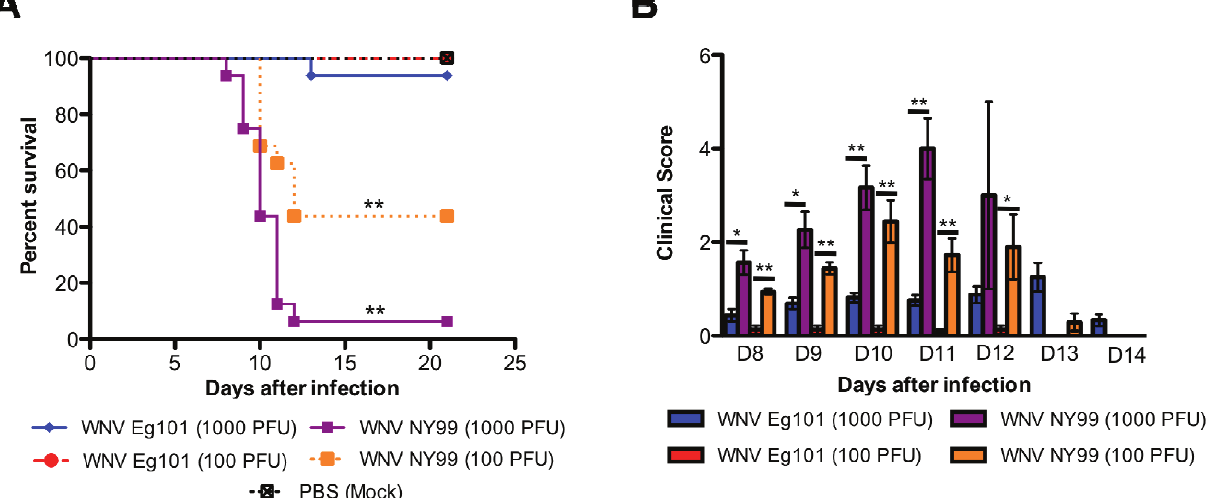
Figure 1. Survival analysis and clinical score of WNV Eg101 and WNV NY99 infected mice. ( A ) Eight-week old C57BL/6J mice were inoculated subcutaneously with 1000 or 100 PFU of WNV Eg101 or WNV NY99. A group of mice were also inoculated with PBS (Mock). All mice were observed for 21 days. Data are combined of two independent studies (n = 16 per group). ( B ) Animals were monitored for clinical scores twice a day. The designation for the clinical scores is as follows: 1, ruffled fur/hunched back; 2, paresis/difficulty walking; 3, paralysis; 4, moribund/euthanized; and 5, dead. Error